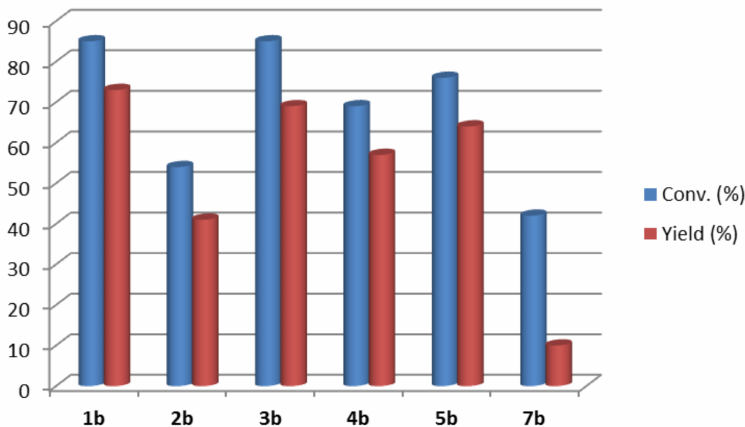
Figure 1. Conversions and isolated yields for the RasADH-catalyzed preparative biotransformations to obtain the optically active diols (1 S ,4 S )- 1 – 5 , 7b